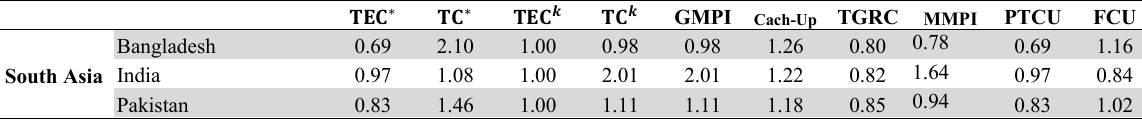
Calculations of Productivity Changes using the metafrontier Malmquist method for South Asia